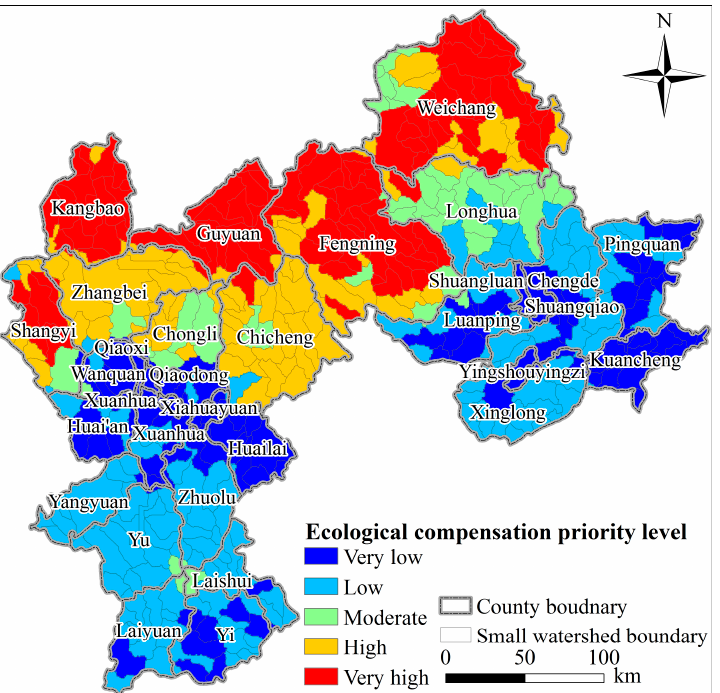
Figure 5. Ecological compensation priority levels in the Poverty Belt around Beijing and Tianjin.